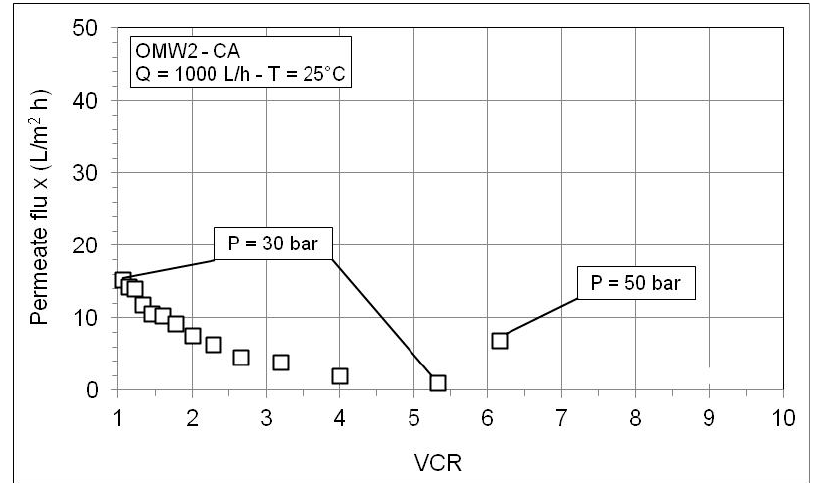
Figure 7. Pure water flux as a function of operating pressure before and after RO test with MF permeate of OMW1-FR.